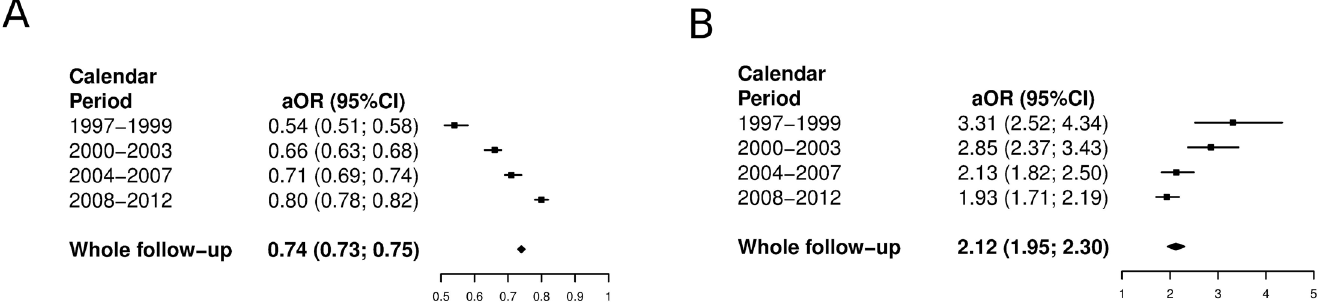
Fig 1. A. Adjusted likelihood of prevalence among HIV-infected subjects diagnosed with diabetes in Spain (1997 – 2012) stratified by HIV status. Fig 1B. Adjusted likelihood of death among HIV-infected subjects diagnosed with diabetes in Spain (1997 – 2012) stratified by HIV status. (A)